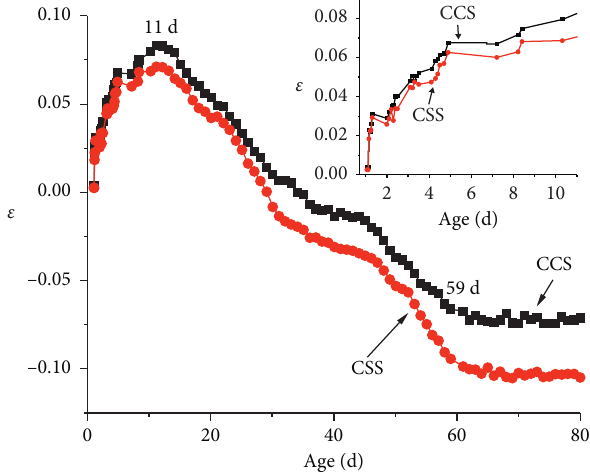
Figure 4: (a) Volume expansion rate of CSS (standard mortar) and CCS (coral mortar). (b) Section of the curve in (a) from 1 to 11d.